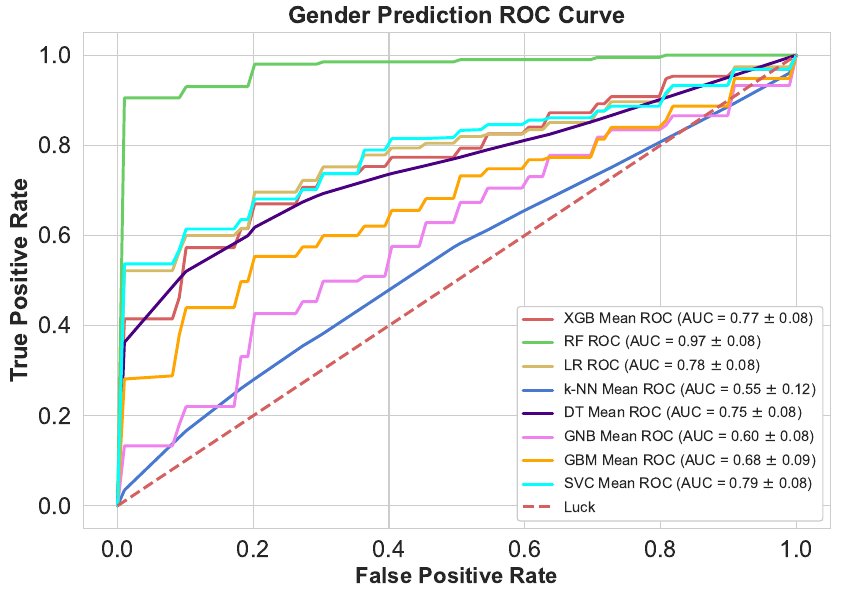
Figure 7. Gender classifiers’ ROC’s at dynamic thresholds.